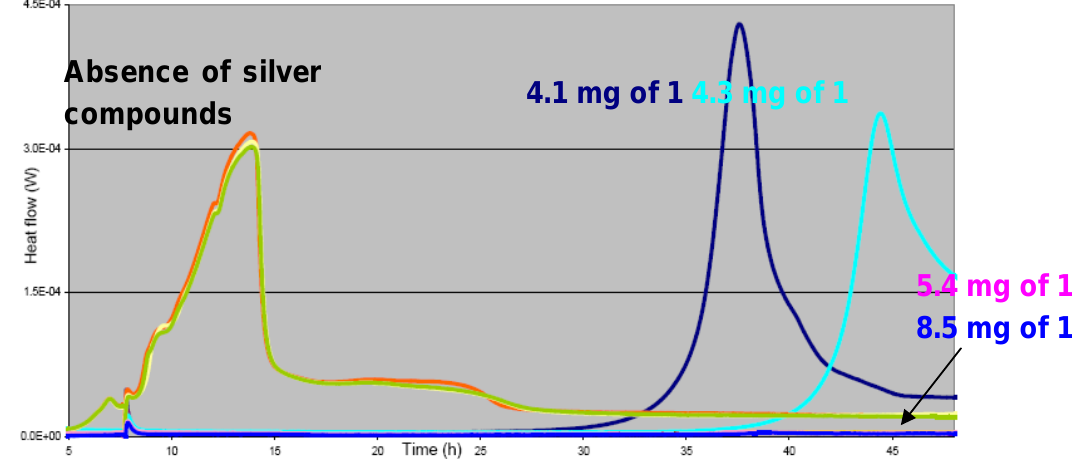
Figure 18. Heat flow curves for S. epidermidis in the absence (green, yellow, orange) and presence (dark blue, light blue, medium blue, pink) of different quantities of compound 1 .